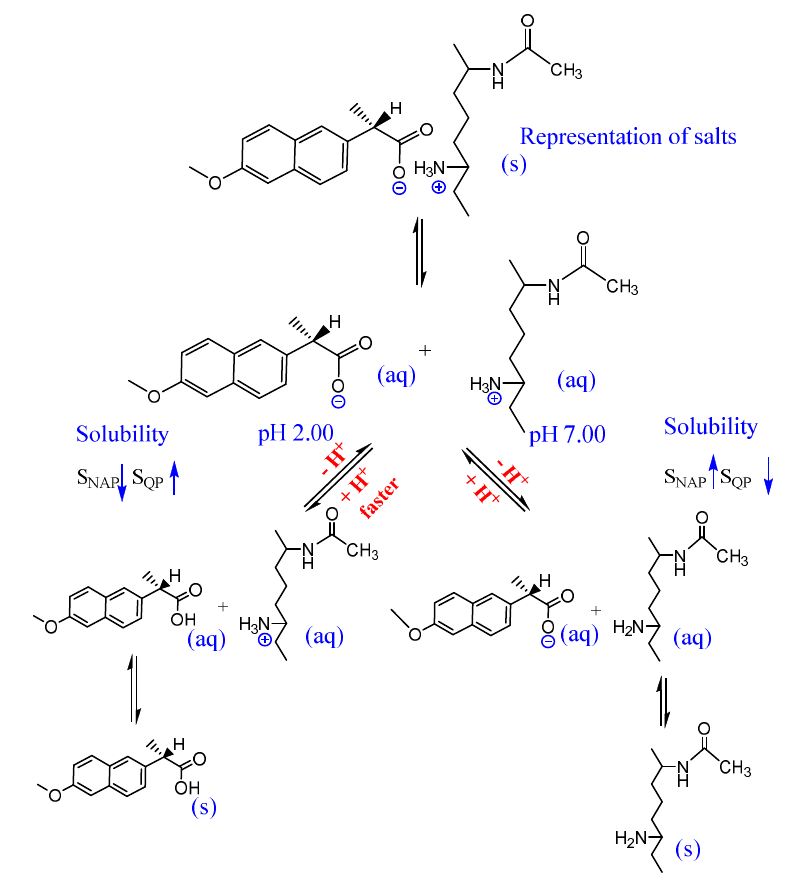
Figure 6. Proposal of dissociation mechanism of NAP from salts.